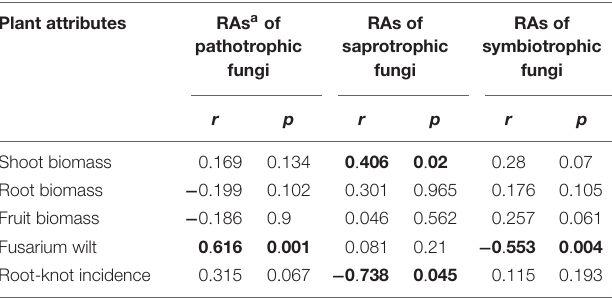
TABLE 3 | The Spearman’s correlation between fungal community functions and above-ground attributes determined by Mantel test. Plant attributes RAs a